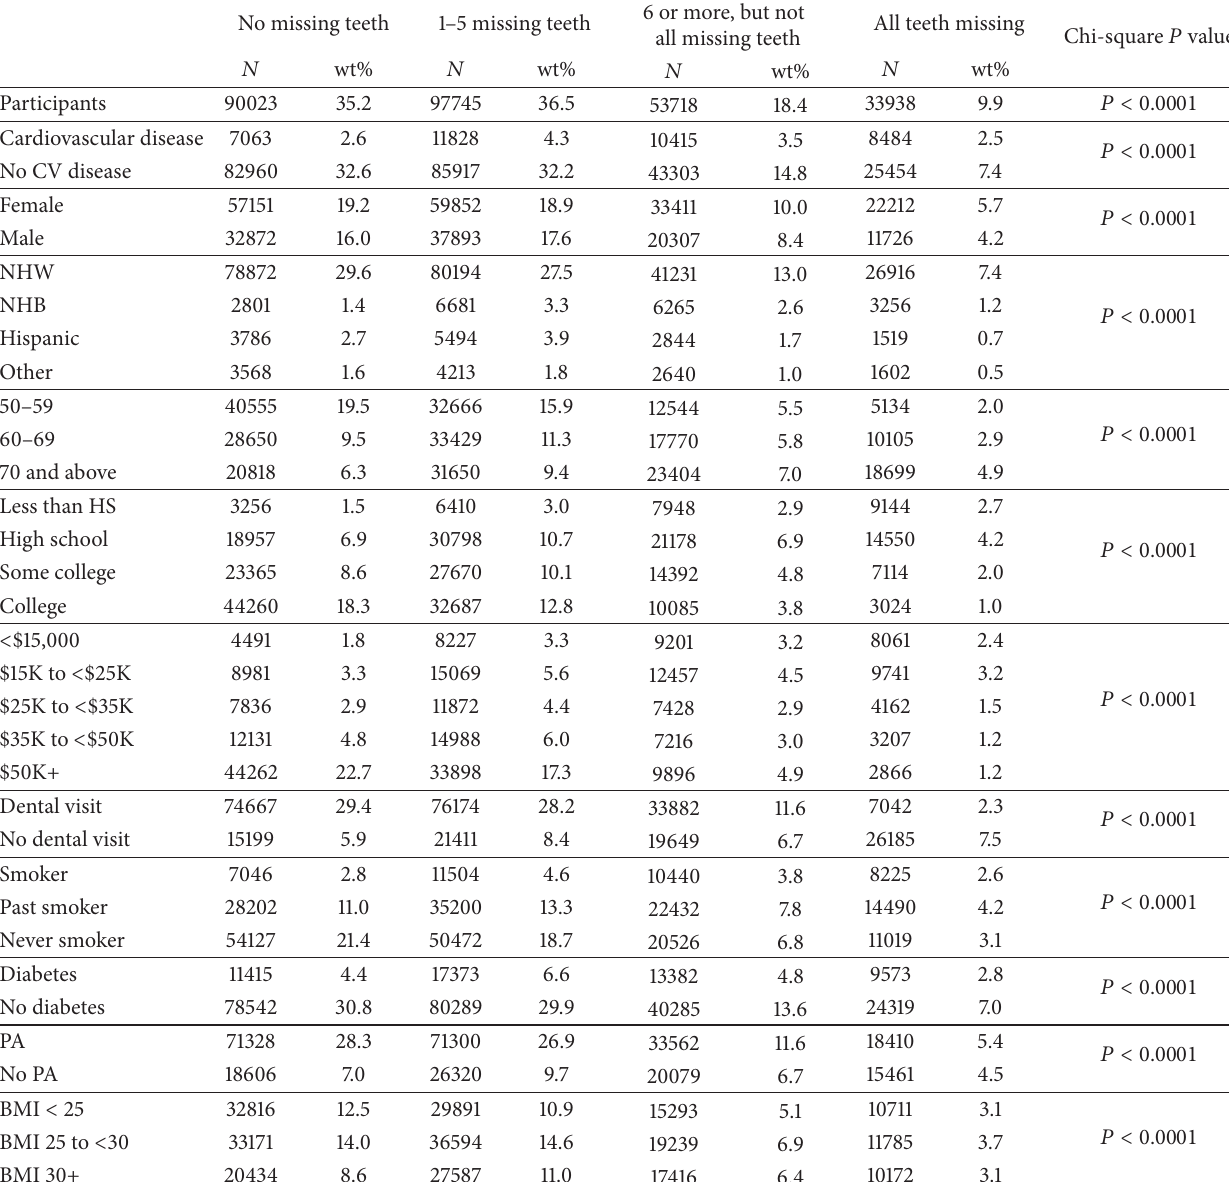
Table 1: Characteristics of the 275,424 study participants according to the number of missing teeth in the behavioral risk factor surveillance system, 2010 ( 𝑁 ,